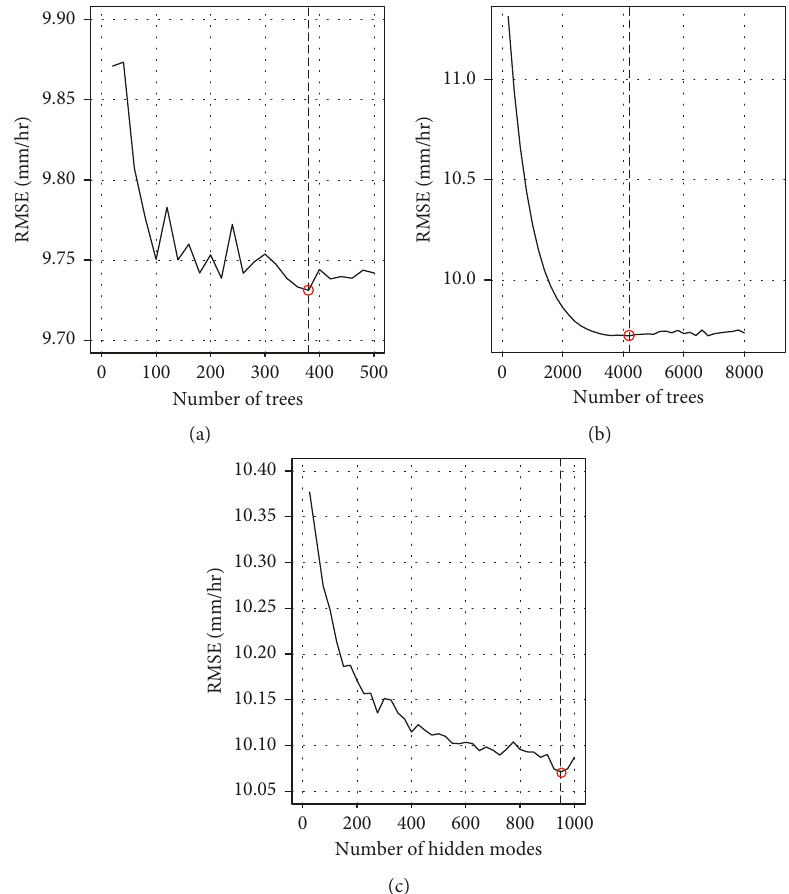
Figure 2: Leave-one-out cross-validation results of hyperparameters for the random forest (the number of trees), stochastic gradient boosted model (the number of trees), and extreme learning machine (the number of hidden nodes) models. The red circles indicate the selected optimal points of the employed hyperparameters based on the root-mean-square error. LOOCV results of (a) RF, (b) GBM, and (c) ELM.